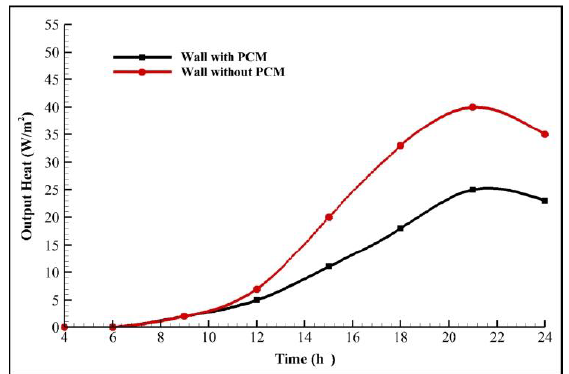
Figure 12. Heat flux through the internal surface of the non ‐ PCM ‐ and PCM ‐ treated south walls.